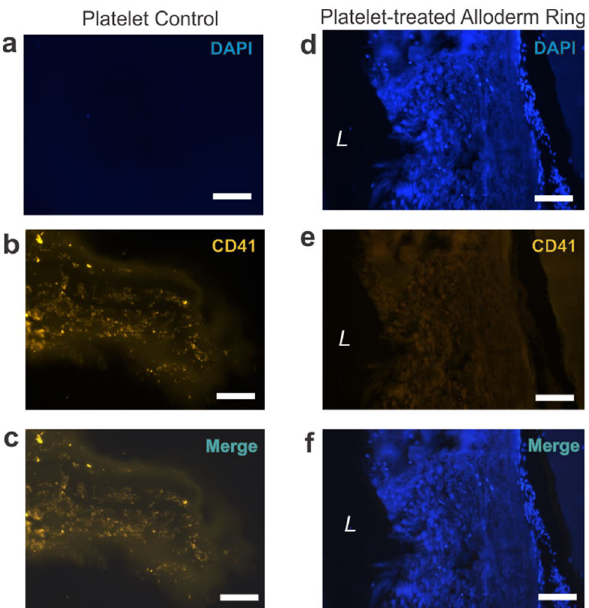
Figure 12. Alloderm rings did not exhibit adhesion to human platelets. Compared to the platelet control ( a–c ), Alloderm rings cultured in human platelets for 24 h ( d–f ) did not exhibit platelet adhesion as evidenced by negative CD41 anti-platelet stain ( e ). DAPI stain demarcated nuclei only evident in the Alloderm rings ( d ). CD41 stain was only positive in the platelet control ( b ). Scale bars = 200